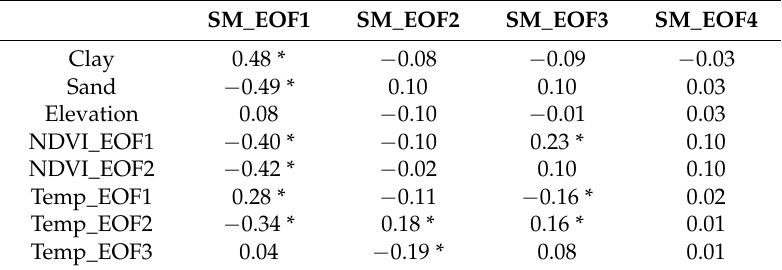
Figure 7. The temporal evolution of the corresponding PCs for the EOFs of normalized difference vegetation index (NDVI) and temperature. Table 3. Pearson’s correlation coefficients ( R )s between the empirical orthogonal functions (EOFs) of S1A_1K and geophysical